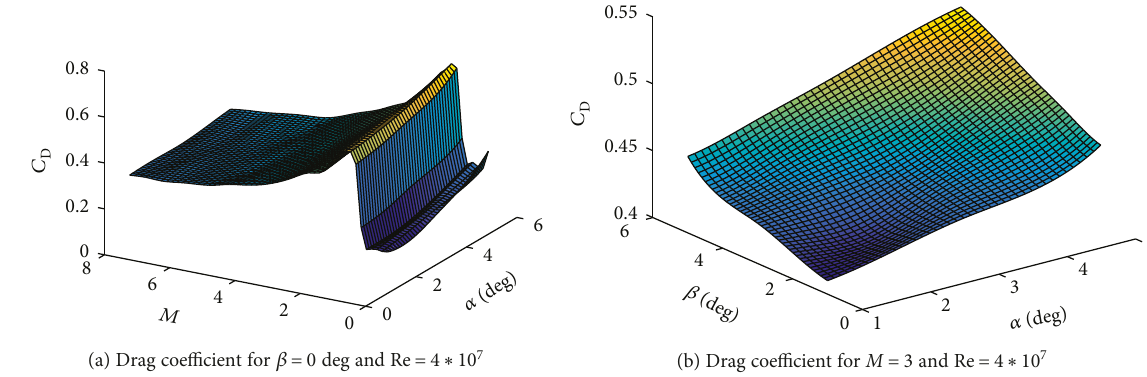
Figure 5: Example of the drag force coe ffi cients provided by the DATCOM software for the con fi guration l = 6 m and d = 0 8 m.